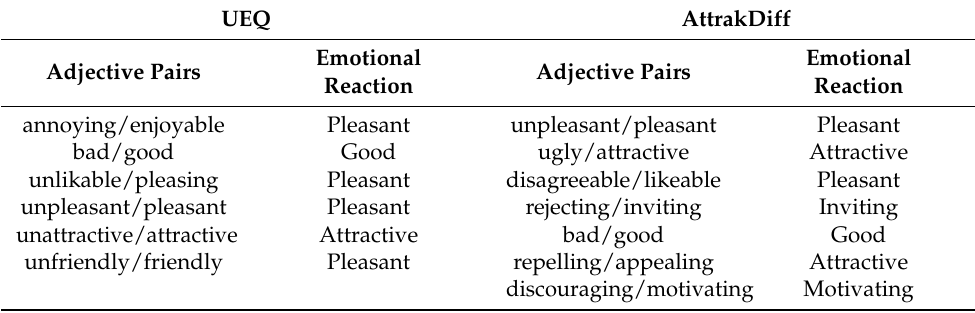
Table 5. Cronbach’s alpha coefficient for